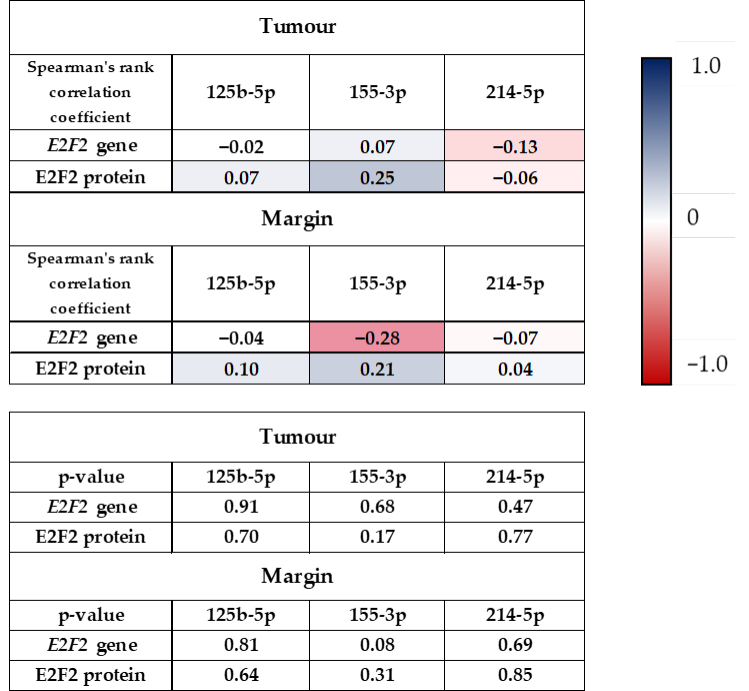
Figure 2. The relative expression levels of tested miRNAs in tumour samples compared to margin samples.